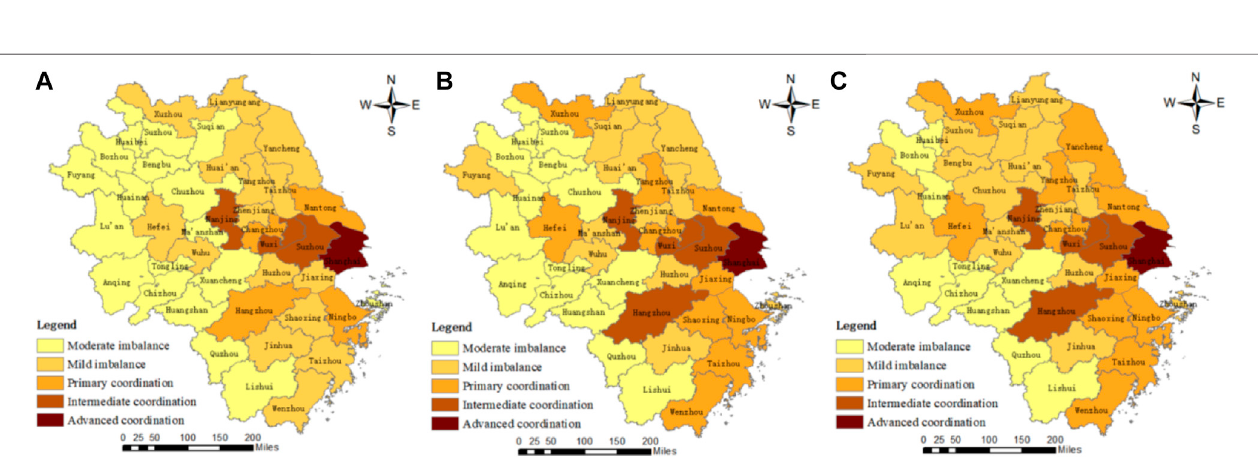
FIGURE 5 | Spatial distribution of coupling coordination degree in the Yangtze River Delta in 2008, 2013, and 2018.